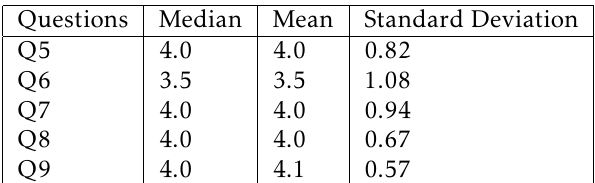
Table 3. Statistics obtained from the participants answers about the user profile panel.